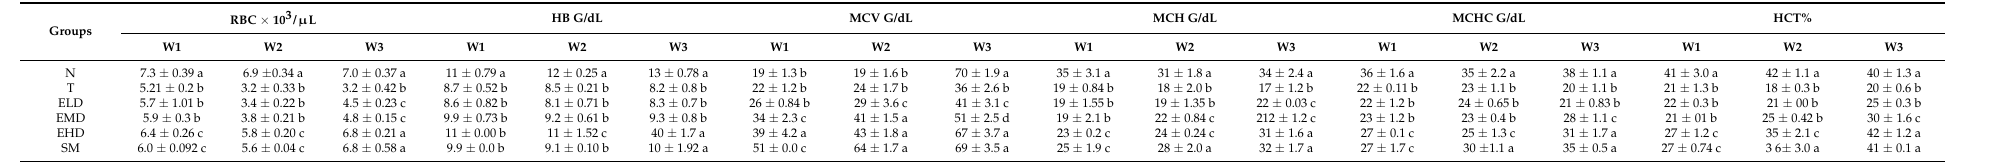
Table 1. The effects of DO.AQ extracts on hematological indices of various experimental groups.